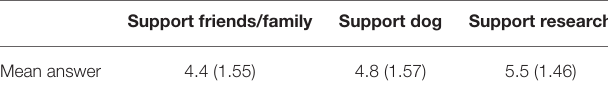
TABLE 4 | Comparison of sources of support (all participants combined), human-centered